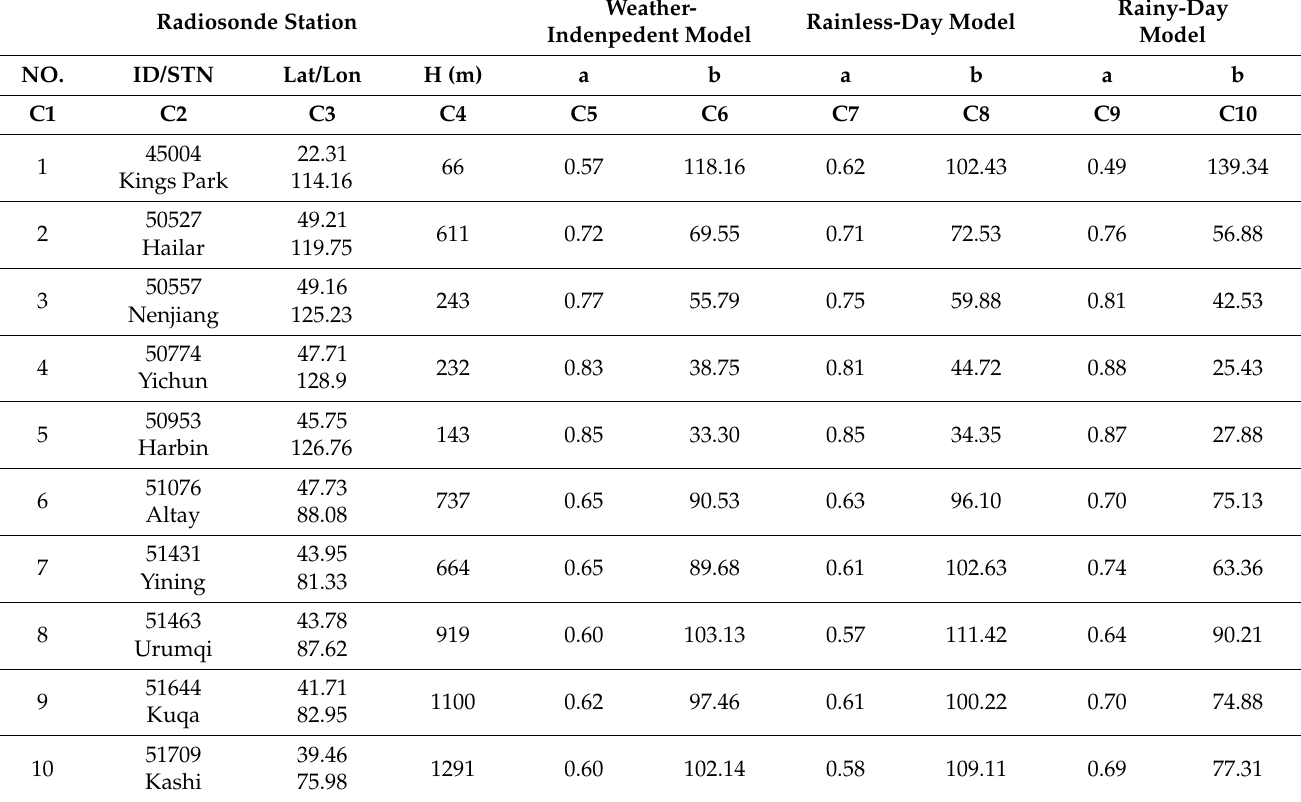
Table A1. Radiosonde station information and site-specific T s ∼ T m linear models. Columns 1 (C1)–4 (C4) present the information of the 88 radiosonde stations. Column 1 shows the series number of the stations. Column 2 shows the station ID and station name. Column 3 shows the latitude